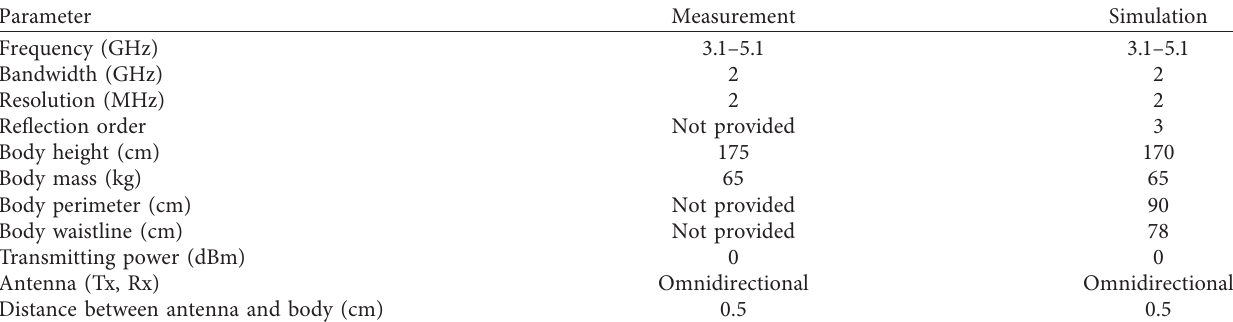
Figure 4: Positions of the Tx and Rx. (a) Measurement [22]. (b) Simulation with human body model 3 in Table 4. Table 5: The parameters of experiment around the chest.